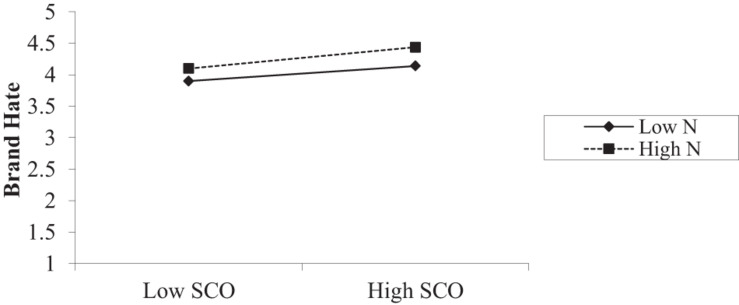
Interaction plot.